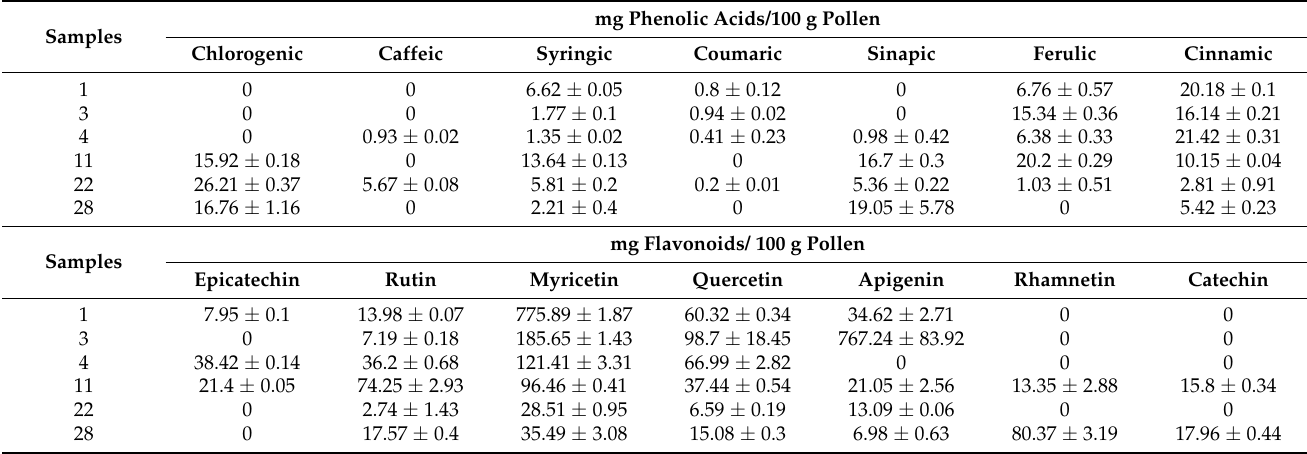
Table 2. Phenolic acids and flavonoids of honeybee pollen extracts (BPE) determined by HPLC-DAD 1 .